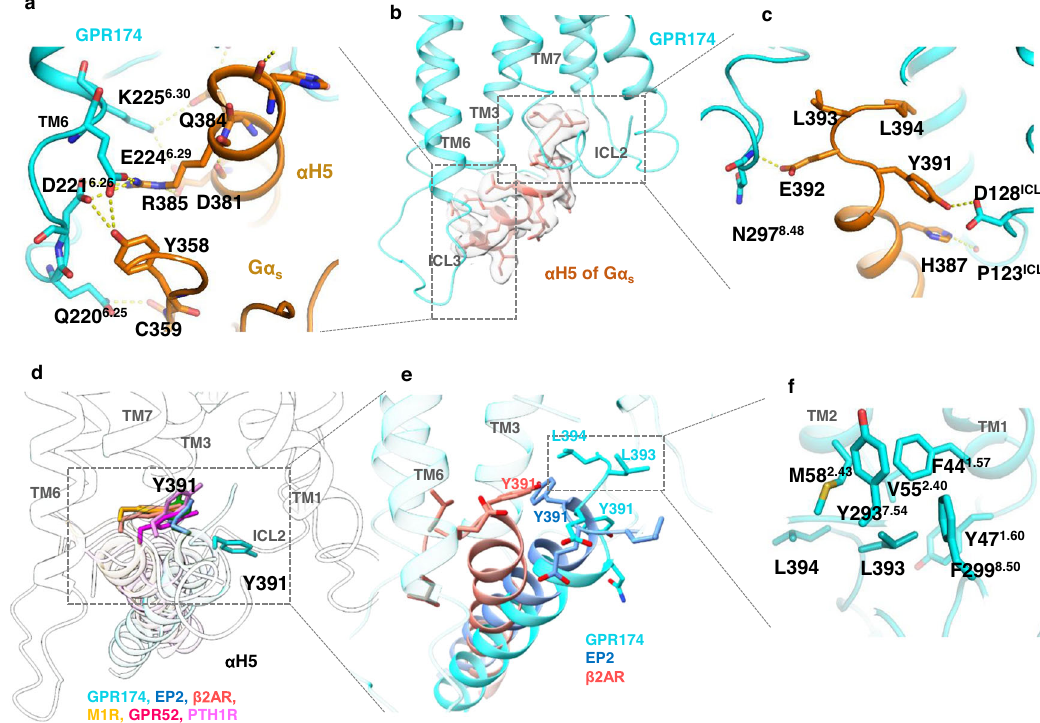
Fig. 5 | The G s engaging model of GPR174. a TM6/ICL3 junction forms extensive polar interaction with G α s . b The overall engagement of α H5. Density map was drawnbychimeraXatamaplevelof0.08. c Thedetailofthe α H5headinteraction. d A superimposition of α H5 engagements in the context of GPR174. e A detailed